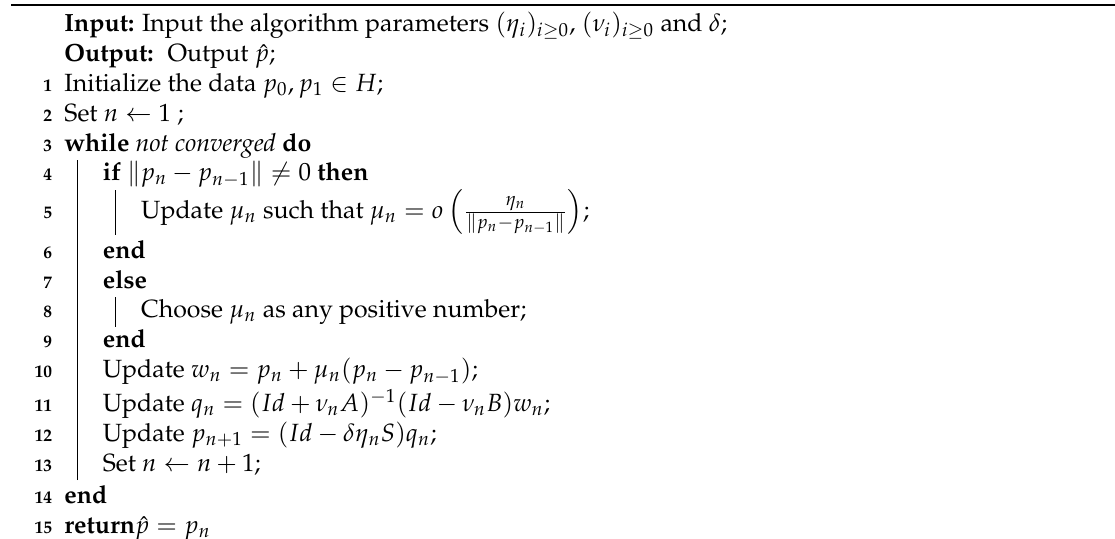
Algorithm 1: The hybrid forward–backward